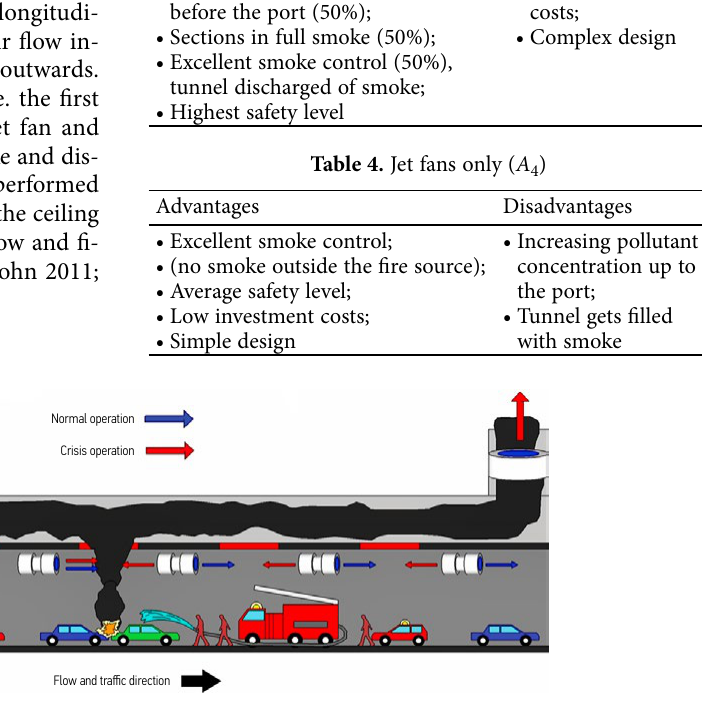
Fig. 3. Longitudinal discharge jet fans with central fans operating in crisis and under normal conditions